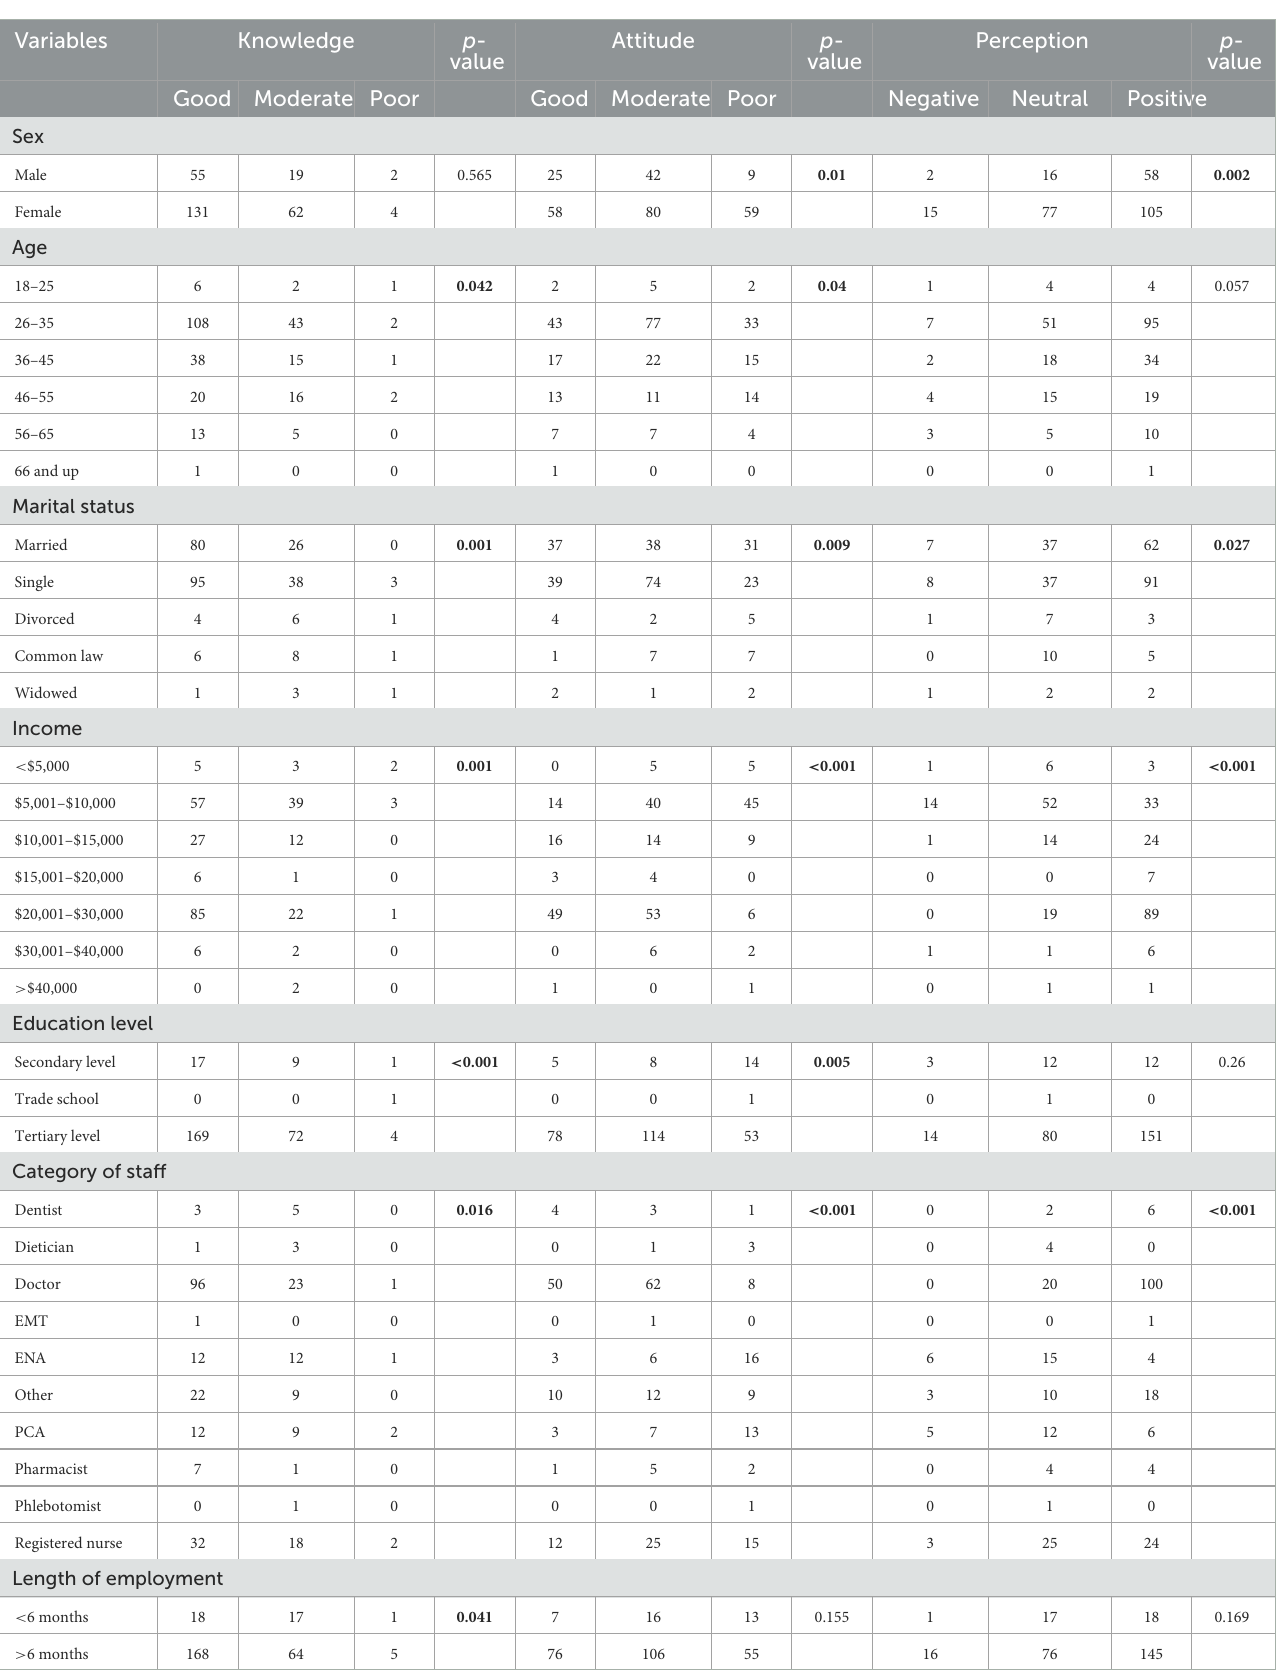
TABLE 2 Participants score by categorization on KAP domains and Chi-square test of association